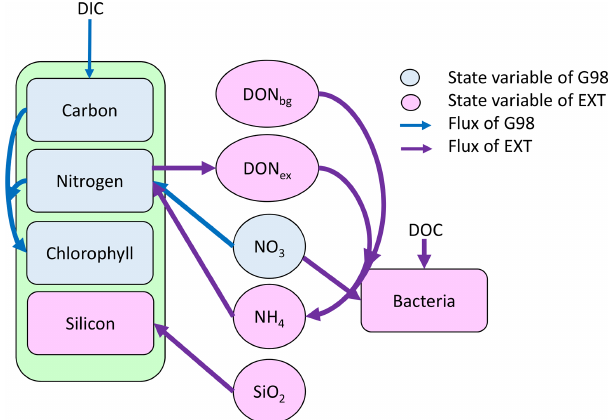
Figure 1. Schematic representation of the state variables and con- nections and controls in the G98 model (blue) and EXT model (pur- ple). The EXT model has the same formulations as G98, with the additions shown in